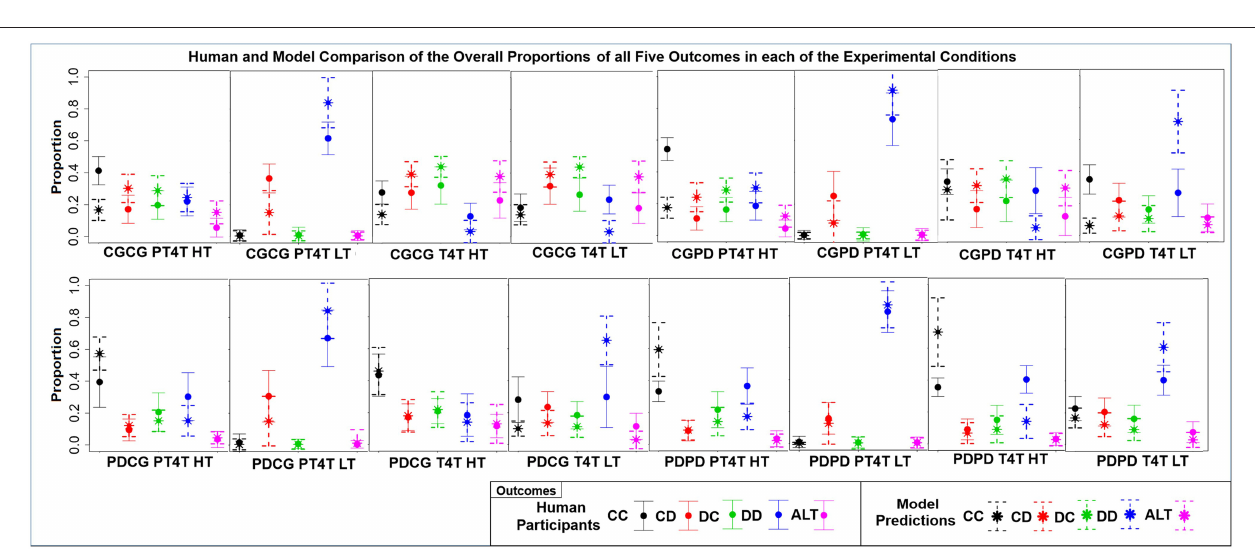
FIGURE 5 | The mean ± one standard deviation of the overall proportion that each of the five outcomes [mutual cooperation (CC), unilateral cooperation (CD), unilateral defection (DC), mutual defection (DD), and alternation (ALT)] was choosen over the course of both games in each of the 16 conditions, during both the model predictions (star and dashed lines) and human participants (dot and solid